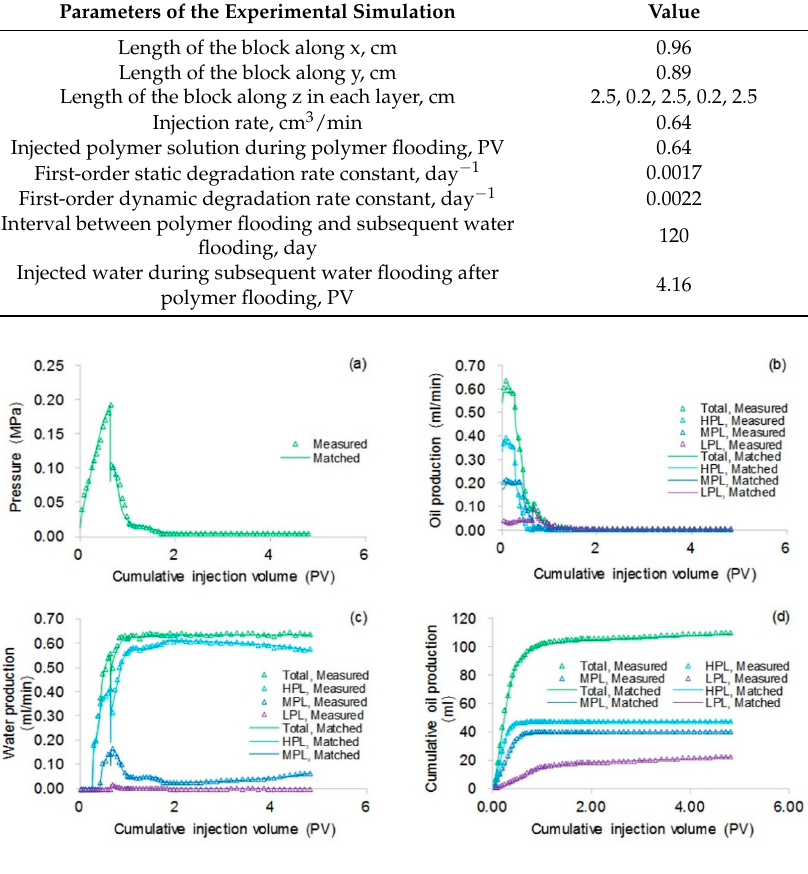
Table 6. The parameters of the experimental simulation, which were different from those for the validation case without polymer